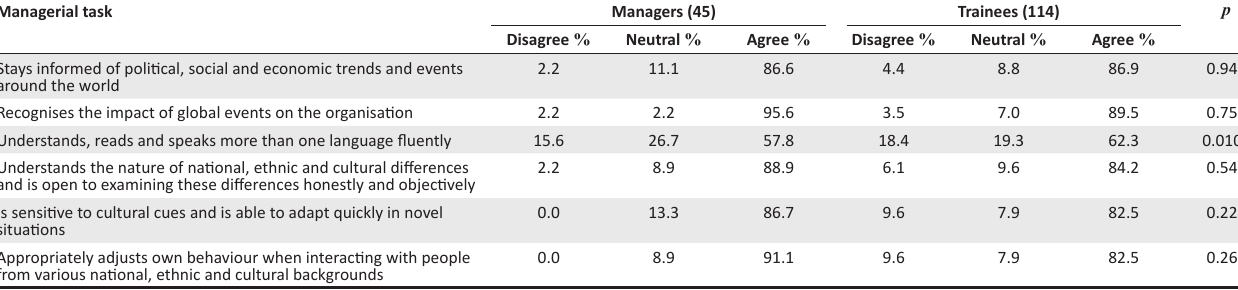
TABLE 8: Result for global